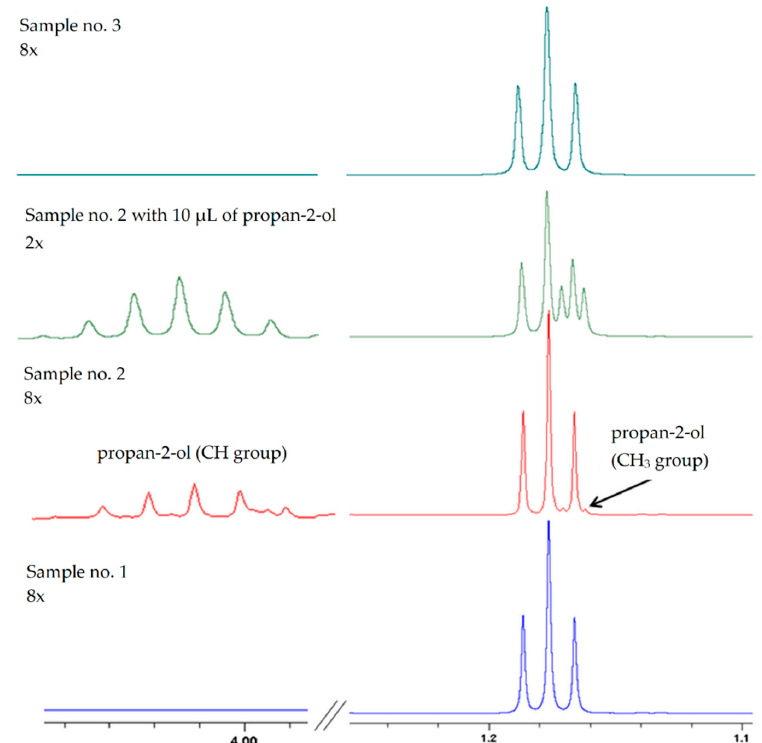
Figure 1. 1 H NMR spectra in the chemical shift region associated with propan-2-ol signals. The methyl group is located at 1.16 ppm, the methine group at 4.01 ppm. (Sample no. 1—distillate obtained from mash inoculated with yeast; Sample no. 2—distillate obtained from mash inoculated with lactic acid bacteria (LAB); Sample no. 3—distillate obtained from mash inoculated with yeast and LAB).